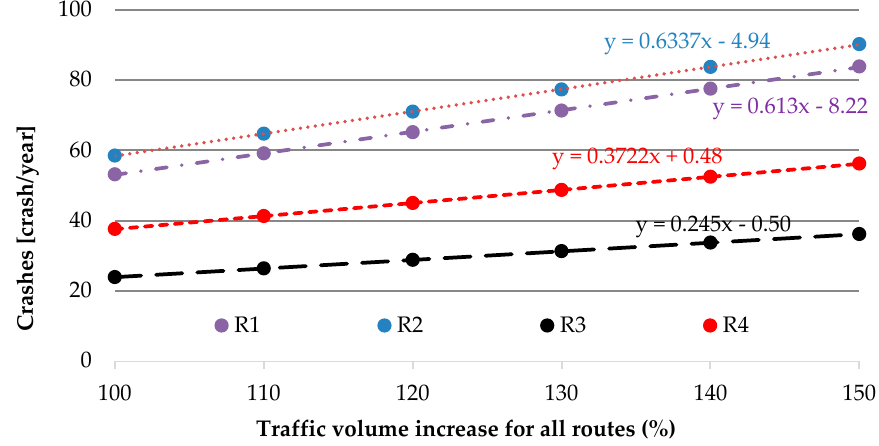
Figure 9. Impact of traffic volume increase for all routes on crashes.